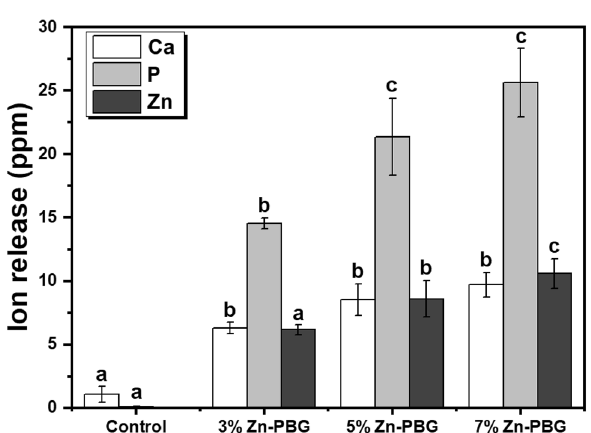
Figure 6. Concentration of ions (Ca, P, and Zn) released from each auto-polymerized acrylic resin sample. The same lowercase letter indicates that there is no statistical difference among the groups for the same